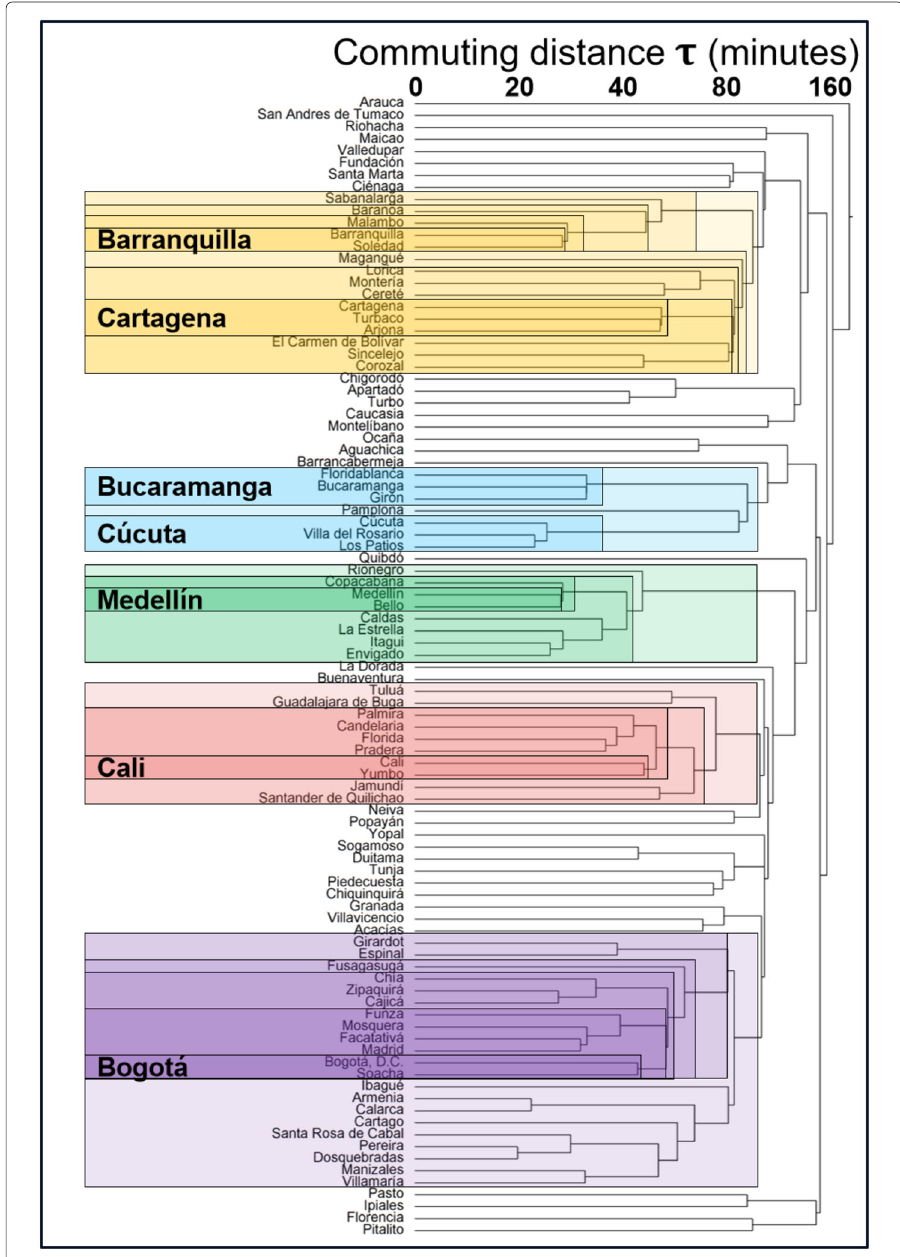
Fig. 3 Dendrogram showing how municipalities are merged into cities (and so on) based on the commuting distance between their centroids. For instance, if the threshold τ = 50 minutes, then Bogotá and Soacha are considered to be part of the same